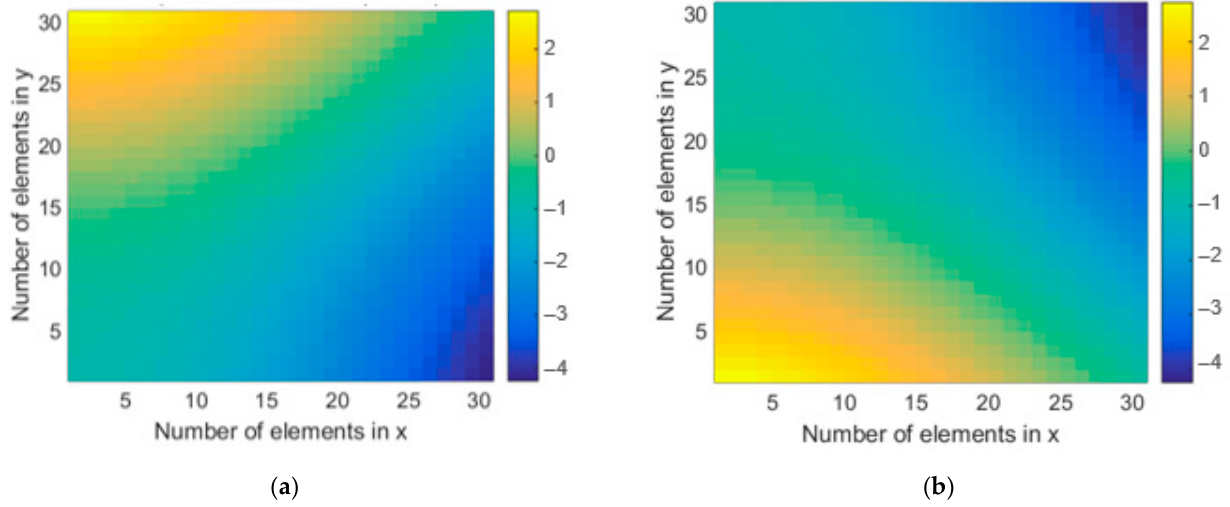
Figure 4. Amplitude difference (in dB) between the x and y components for ( a ) the incident LP at 45 ◦ slant and ( b ) the incident LP at − 45 ◦ slant.